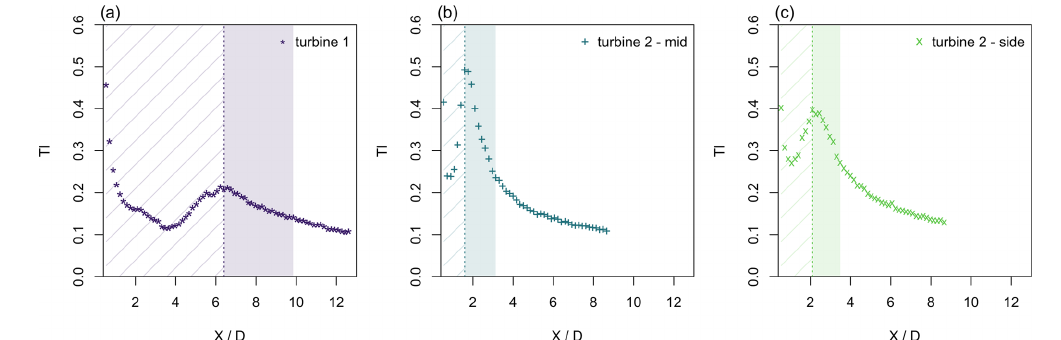
Figure 2. Centerline turbulence intensity TI for the three different inflow conditions: (a) turbine 1 – laminar inflow, (b) turbine 2 mid – turbulent, and (c) turbine 2 side – turbulent and intermittent. The vertical lines mark the maximum of the TI ( X/D = 6 . 24 for turbine 1, X/D = 1 . 79 for turbine 2 mid, and X/D = 2 . 45 for turbine 2 side); the hatched regions upstream of the turbulence intensity maximum mark the regions that will be omitted in the following; and the colored area marks the region where the Taylor Reynolds number is changing (cf. Fig. 3).